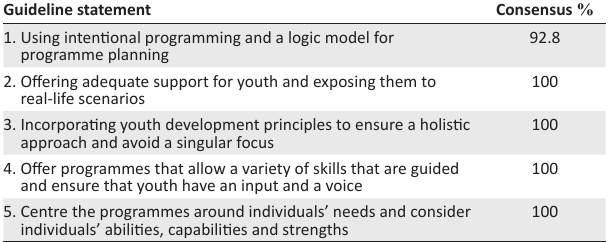
TABLE 8: Guidelines on balancing leisure education programmes to promote holistic development among youth with physical disabilities.